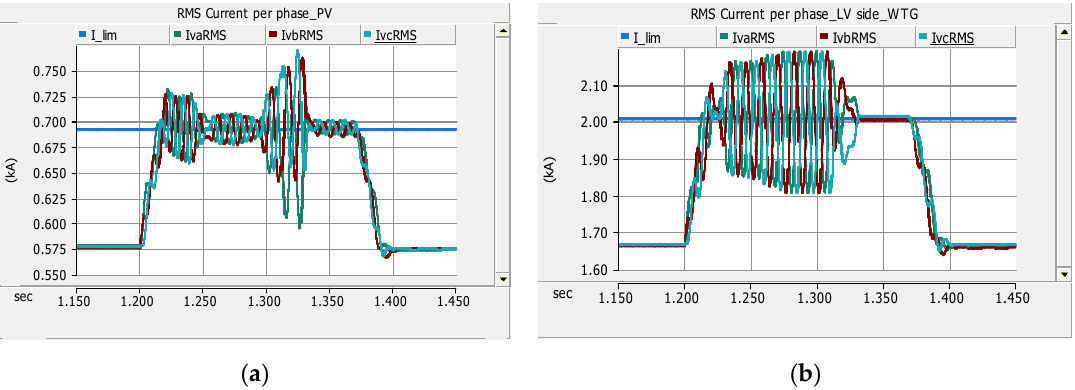
Figure 14. RMS magnitude of the current per phase of DGs before, during and after fault F1 (adaptive IED2 trip): ( a ) LV side of the PV system and ( b ) LV side of the WTG. Note: At 1.29–1.3 s, CB1 trips (Figure 10a), and at 1.37 s, CB2 adaptively trips (Figure 12b).